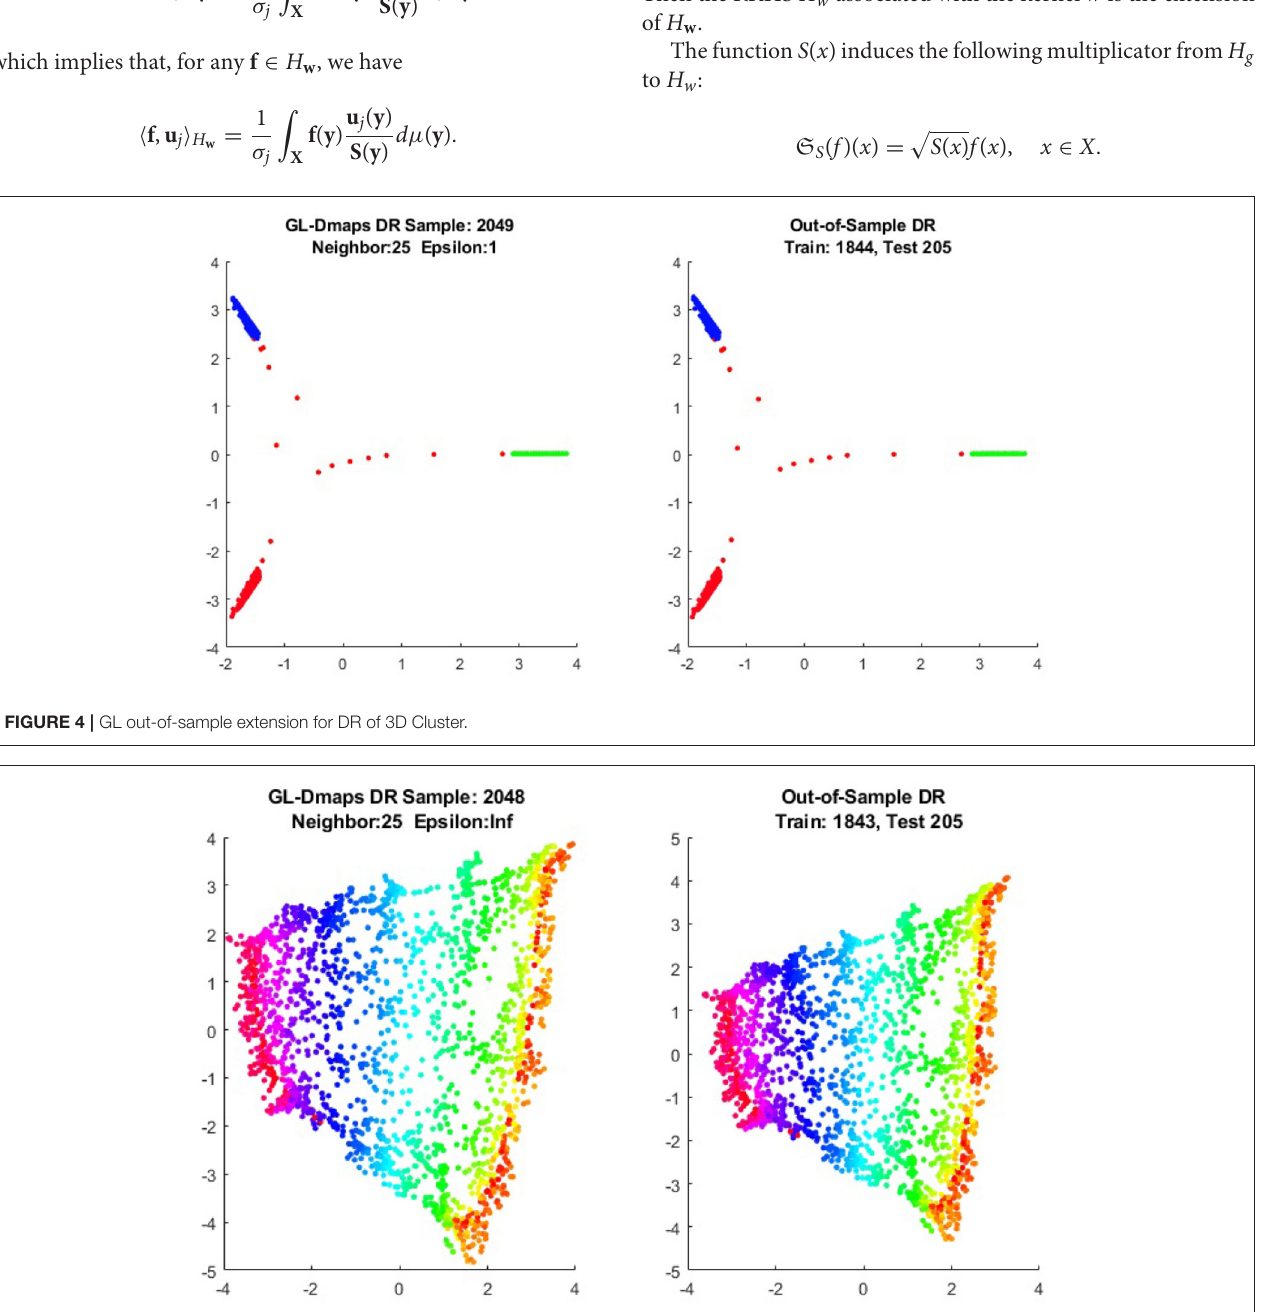
FIGURE 5 | GL out-of-sample extension for DR of Swiss